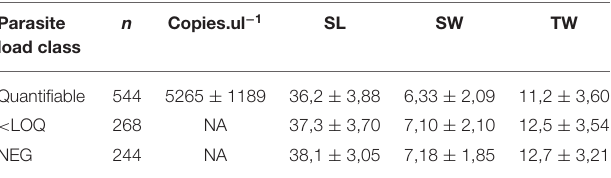
TABLE 4 | Means and SD for shell length (SL), shell weight (SW), and total weight (TW), presented in three clam groups depending on the parasite load (negative; below LOQ; quantifiable for parasite DNA) for experimental F1 clams in the Chioggia field challenge.